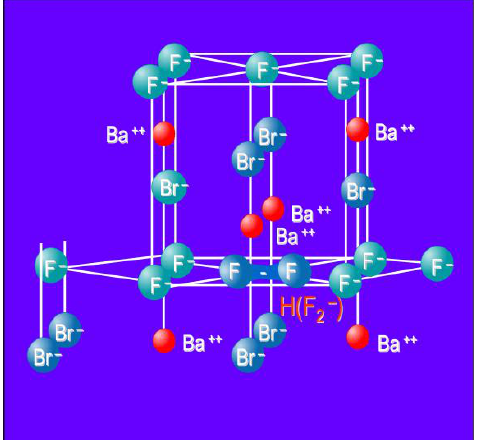
Figure 13. Model of the BaFBr lattice cell with H (F 2− )